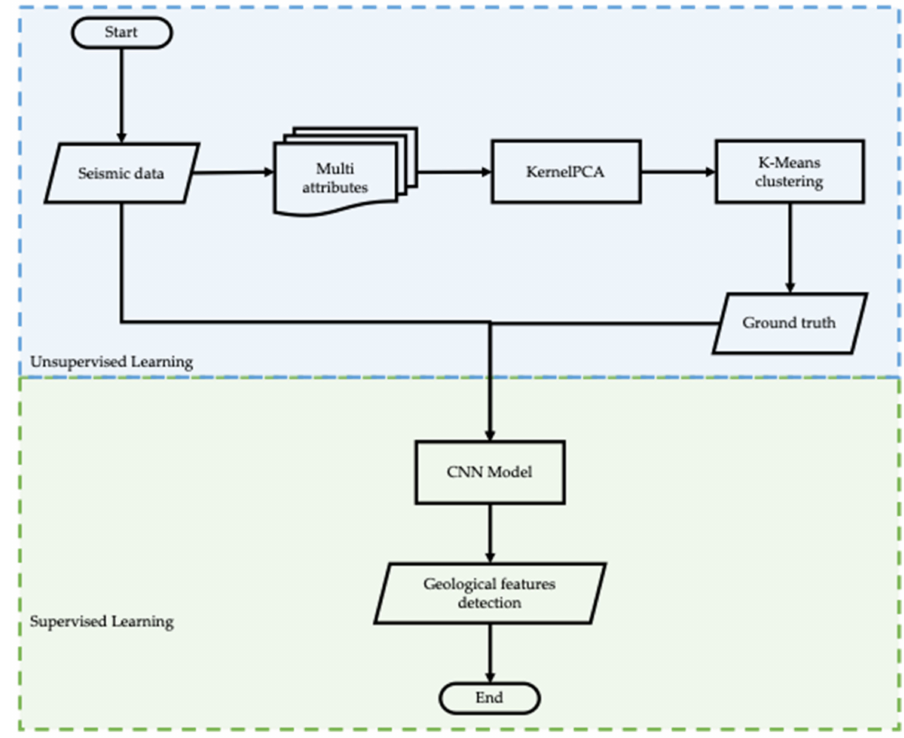
Figure 5. The proposed workflow of automatic geological features detection using semi-supervised